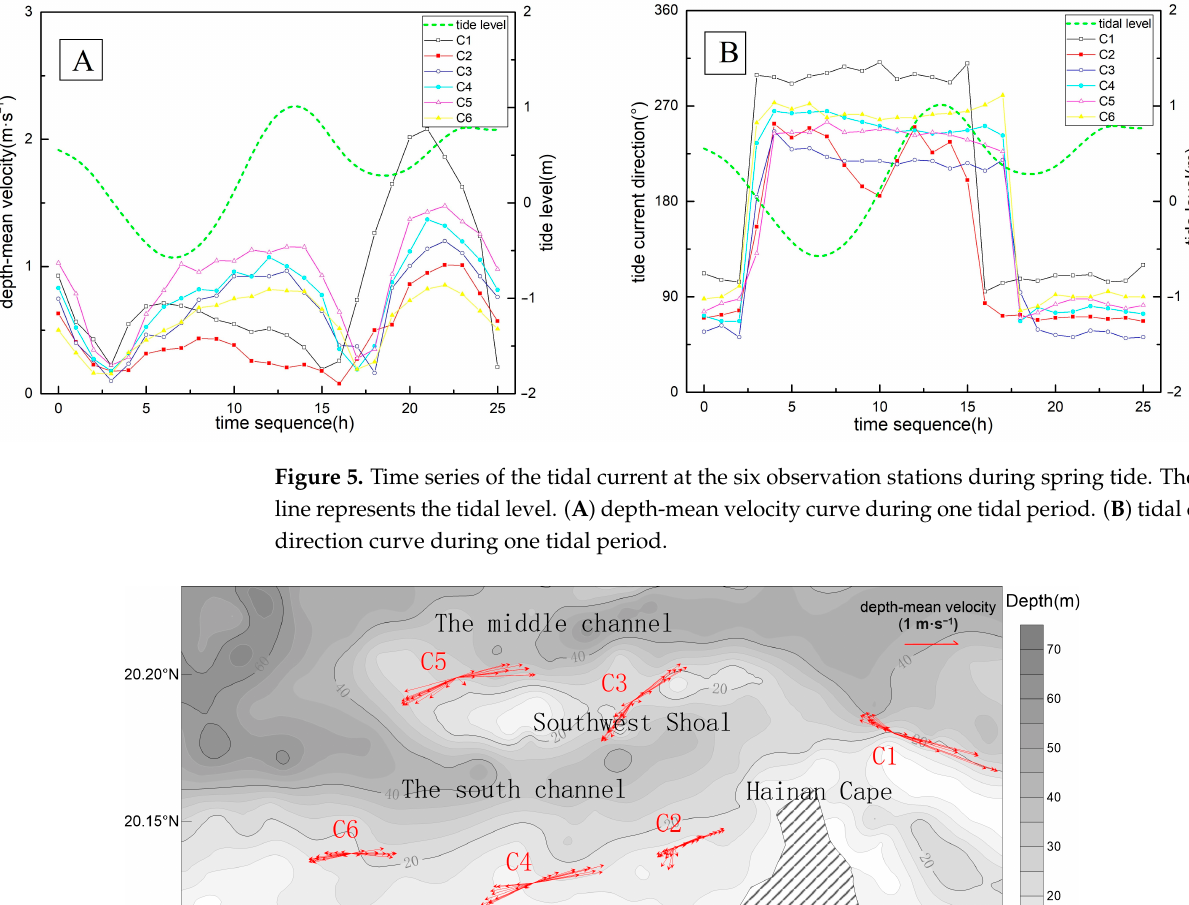
Figure 5. Time series of the tidal current at the six observation stations during spring tide. The green line represents the tidal level. ( A ) depth-mean velocity curve during one tidal period. ( B ) tidal cur- rent direction curve during one tidal period.